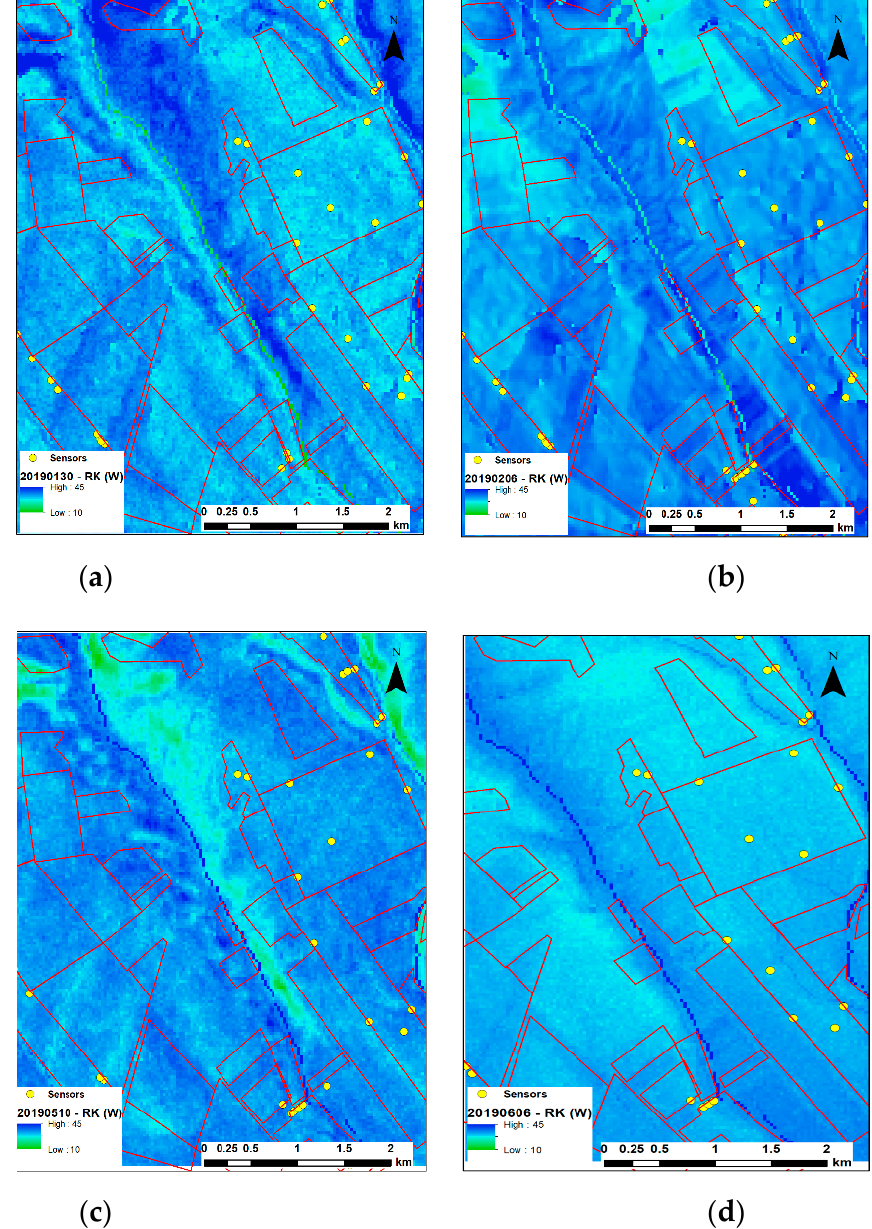
Figure 10. Wheat land use: Error-corrected prediction regression kriging soil moisture map (V%)— ( a ) January 2019, ( b ) February 2019, ( c ) May 2019, and ( d ) June 2019,